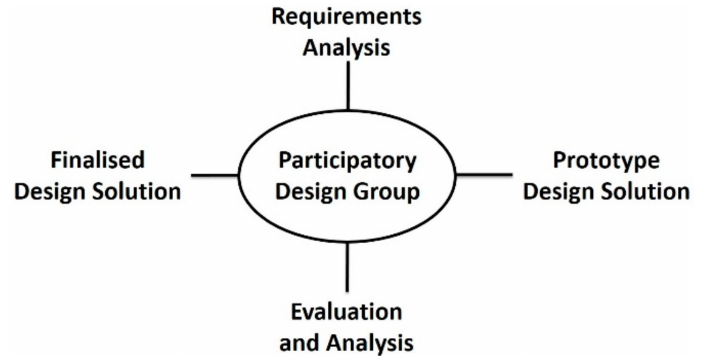
Figure 1. Participatory Design interaction within the Design Process